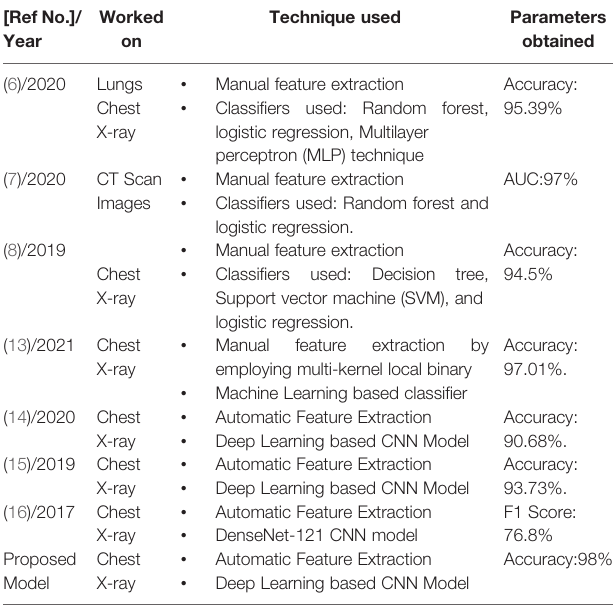
table that the highest recognition accuracy obtained by the proposed work is 98% by employing CNN based deep learning model in which automatic feature extraction takes place while others have achieved less accuracy.